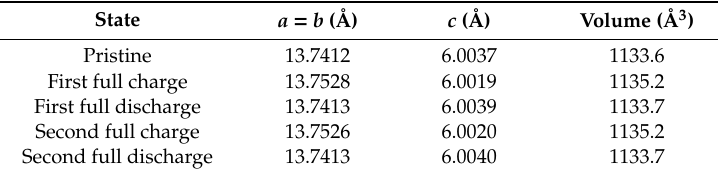
Table 1. Variation of lattice parameters and volume of pristine NbO 2 during charge and discharge.